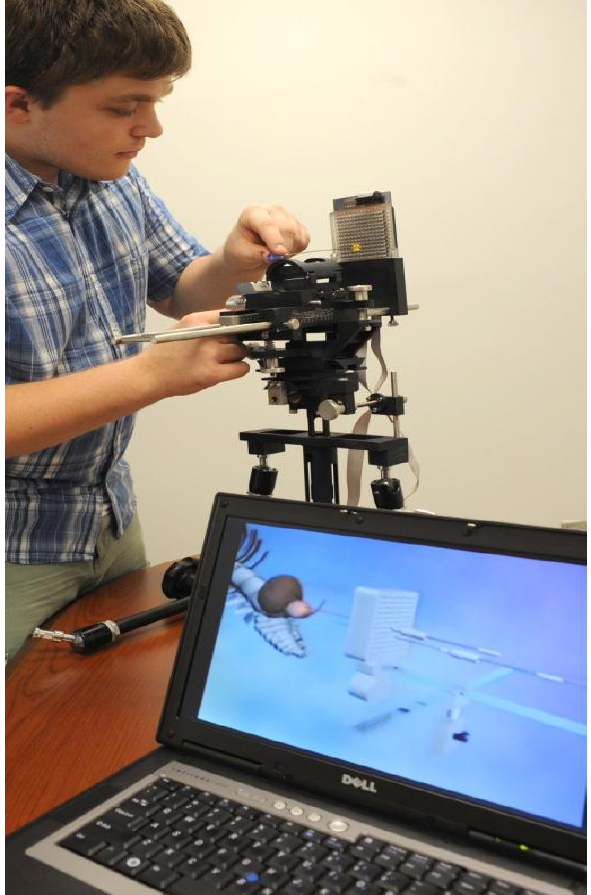
Figure 5. The lighting system aids in accurate placement of radioactive seeds during Brachy therapy.